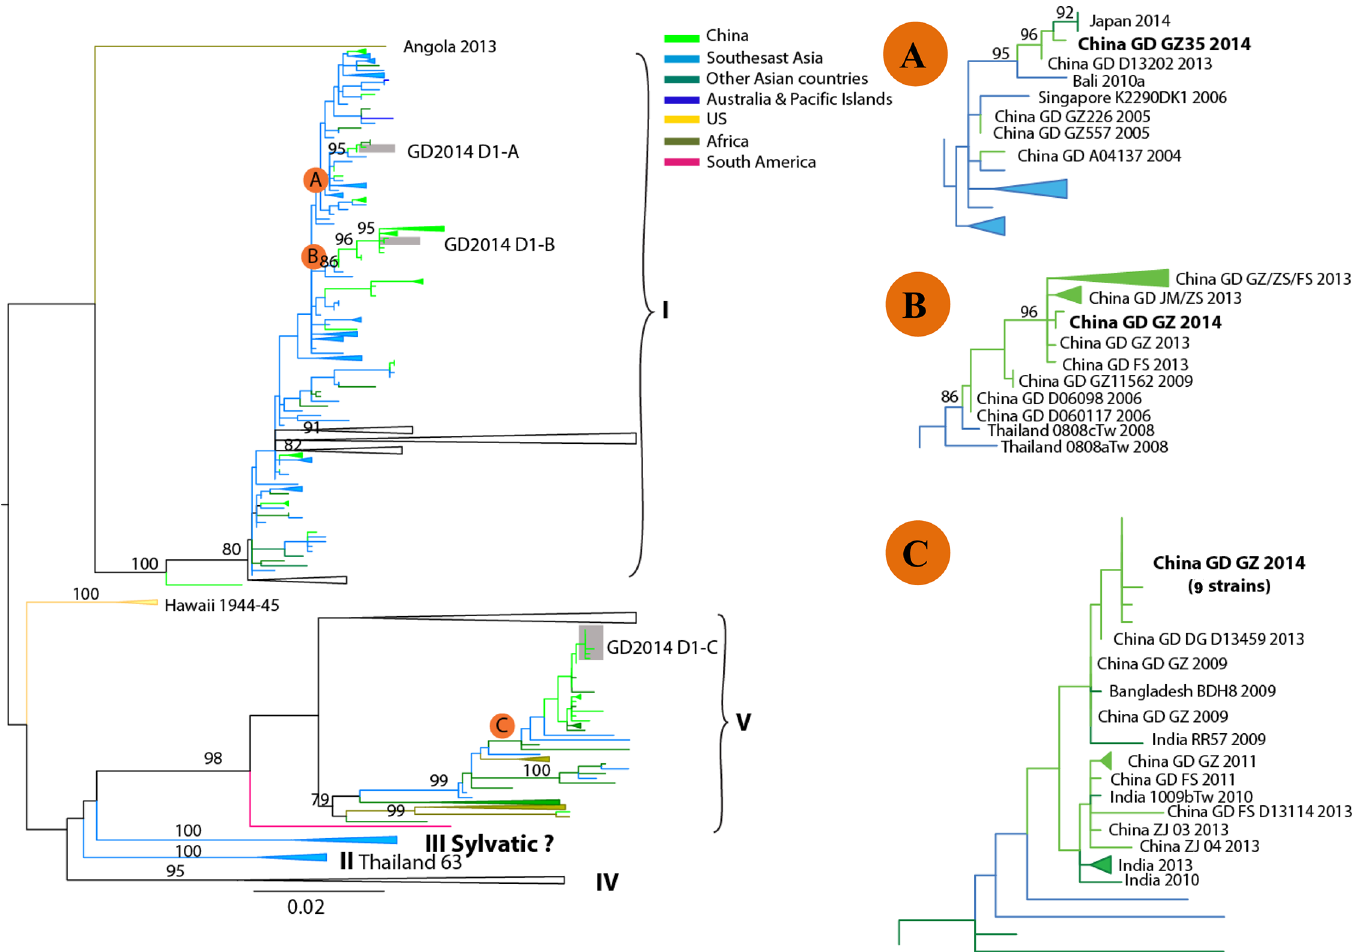
Fig 2. Phylogenetic tree of dengue virus serotype 1 (DENV-1) sequences from Guangzhou compared with other DENV-1sequences deposited in GenBank. The tree was constructed on the basis of complete sequence of the E gene. Sequences from different geographic regions are shown by different colors. For clarity, the GD2014 D1-A, B and C epidemic clade is shown enlarged in the inset at right. Scale bar indicates nucleotide substitutions per site. Strains are labeled as follows: location strain name date (year) of collection. China GD GZ 2014 of the B clade represent a group of the newly obtained sequences from this outbreak, including GZ32 and GZ84 strains. China GD GZ 2014 of the C clade represent GZ01, GZ02, GZ09, GZ27, GZ33, GZ37, GZ44, GZ48 and GZ81 strains from this outbreak. Abbreviations: GD (Guangdong province); GZ (Guangzhou city); ZS (Zhongshan city); FS(Foshan city); JM (Jiangmen